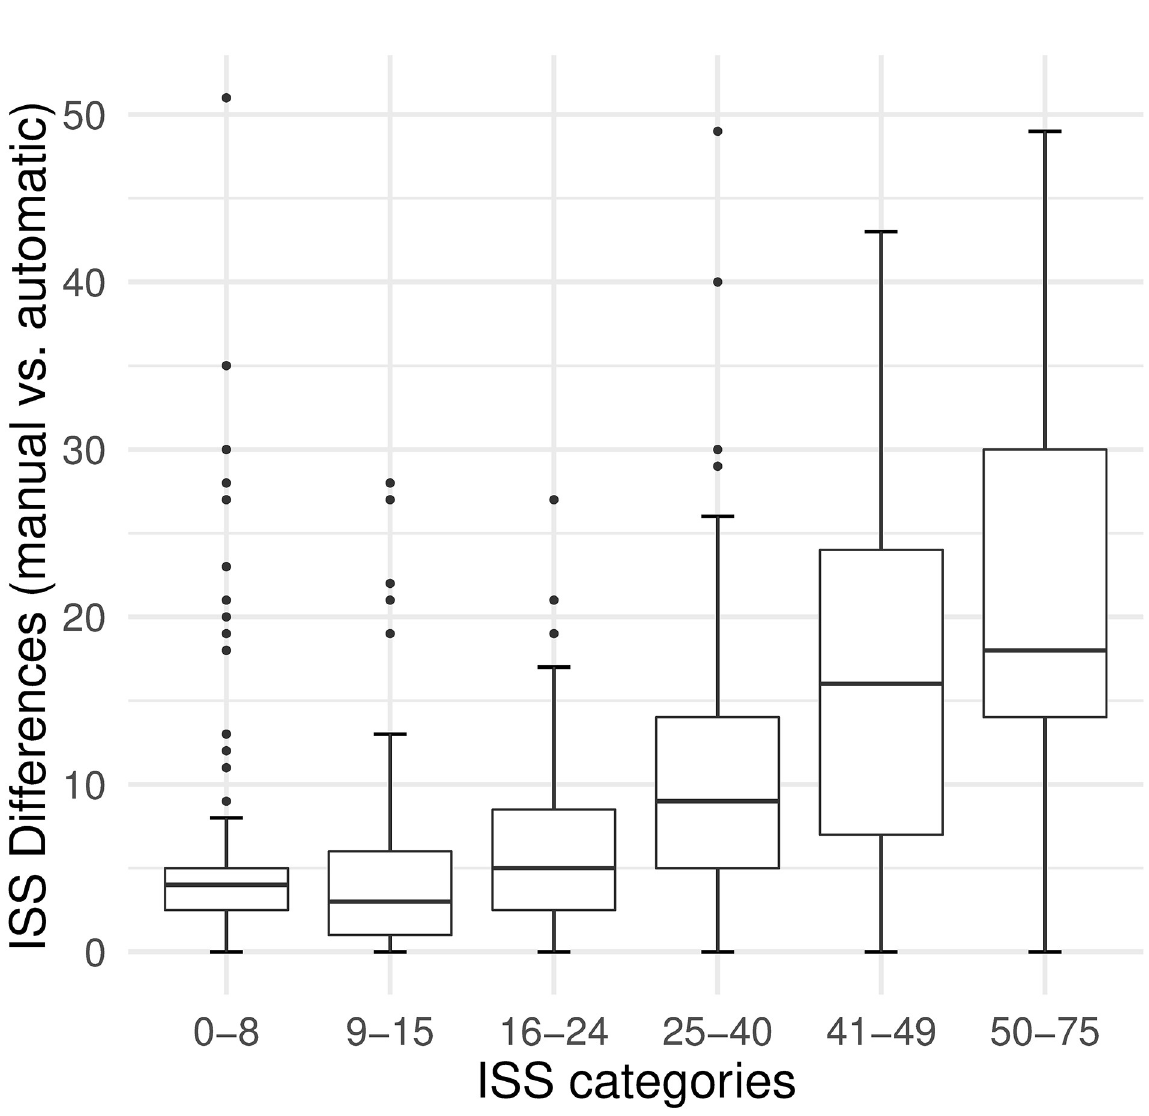
Fig 3. Individual absolute differences between the manual and the automatic ISS calculation. Group 1: ISS 0–8. Group 2: ISS 9–15. Group 3: ISS 16–24. Group 4: ISS 25–40. Group 5: ISS 41–49. Group 6: ISS 50–75. ISS = Injury Severity